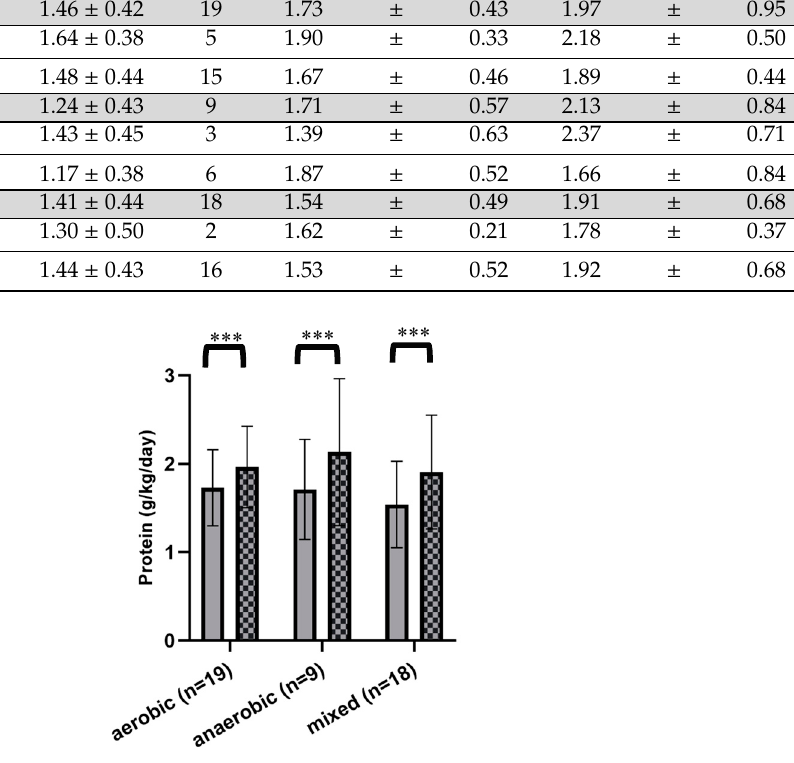
Figure 2. Graphical representation of the e ff ect of protein supplementation for athletes who choose to supplement their diet with protein. Gray bars represent the daily protein intake excluding supplements, checkered bars represent matched individuals’ intake including protein from supplements. Two-way ANOVA repeated measures showed a significant e ff ect of supplementation (F (1, 43) = 79.43, p < 0.0001), and Sidak’s multiple comparisons test showed that supplementation was e ff ective in all sport groups, *** = p < 0.001. Table 3. Mean of protein daily intake dividing the cohort among athletes who supplement with protein and athletes who do not.